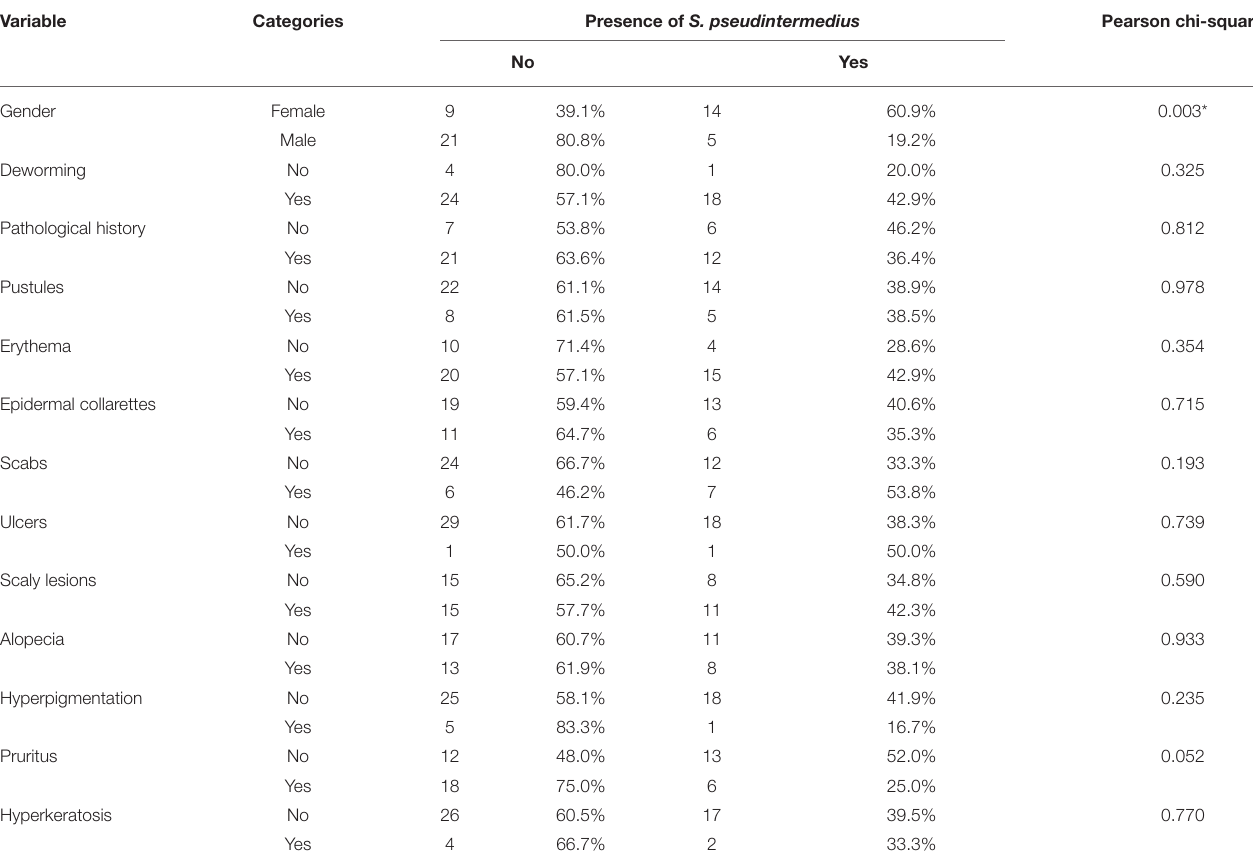
TABLE 5 | Relationship between qualitative variables and the confirmed presence of Staphylococcus pseudintermedius .